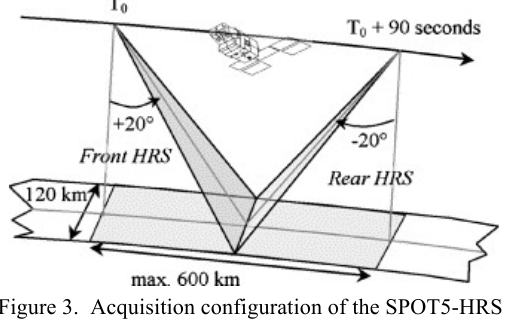
Figure 3. Acquisition configuration of the SPOT5-HRS instrument (Bouillon et al., 2006) Pléiades data. Contrary to SPOT5-HRS images, Pléiades images are not only panchromatic but have 4 channels: Red, Green, Blue and Near Infrared (NIR). In addition, they are featured by a ground pixel of 70cm. In our project, we also assume to have time series, in a similar way as for SPOT5-HRS